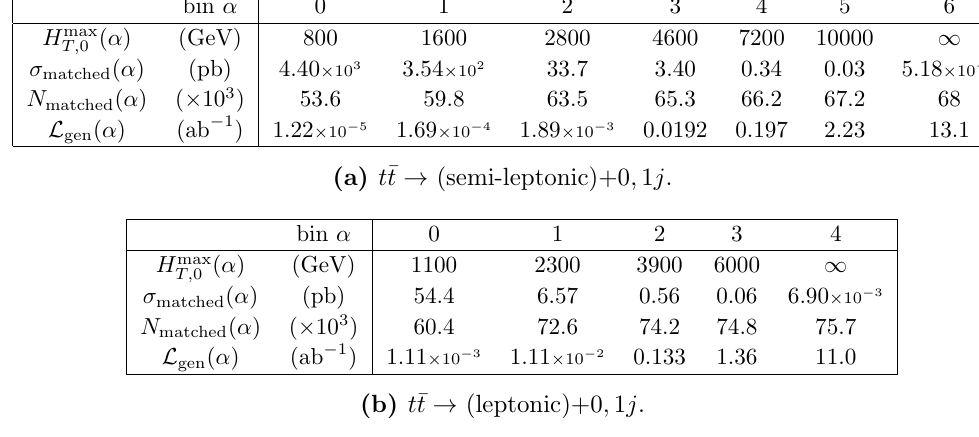
Table 12. Same as in table 10 but for the t (cid:22) t production process.